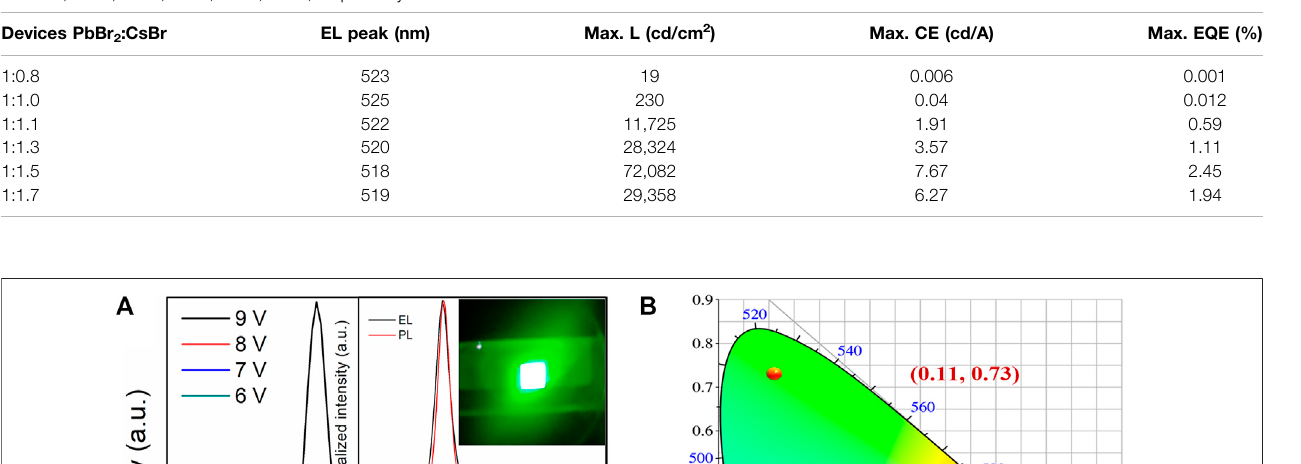
Frontiers in Chemistry |